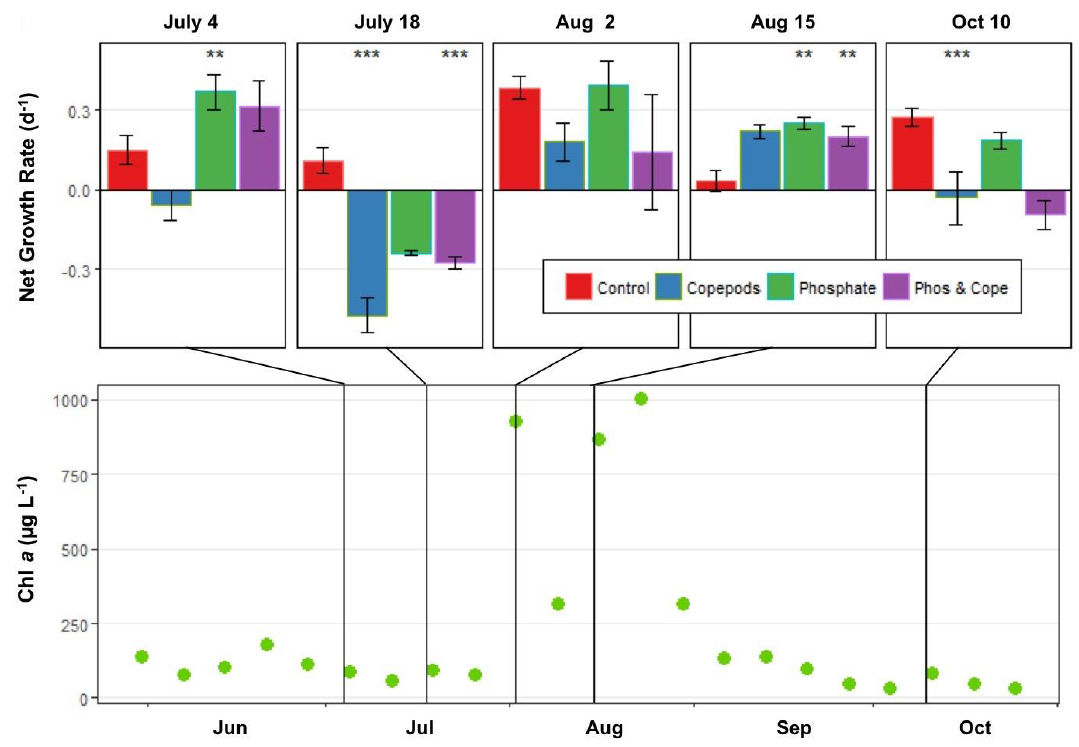
Figure 13. Mean (±SE) net growth rate (day −1 ) of phytoplankton biomass in the controls and three treatments from each of five experiments conducted over the 2013 bloom cycle (upper panel) [asterisks indicate significance of the treatments ‘copepods,’ ‘nutrients,’ and ‘copepods & nutrients,’ as analyzed by two-way ANOVA: p < 0.05 (*), p < 0.01 (**), and p < 0.001 (***)]. Chl a concentrations measured bi-weekly from June-October 2013 (lower panel). Data from [49].